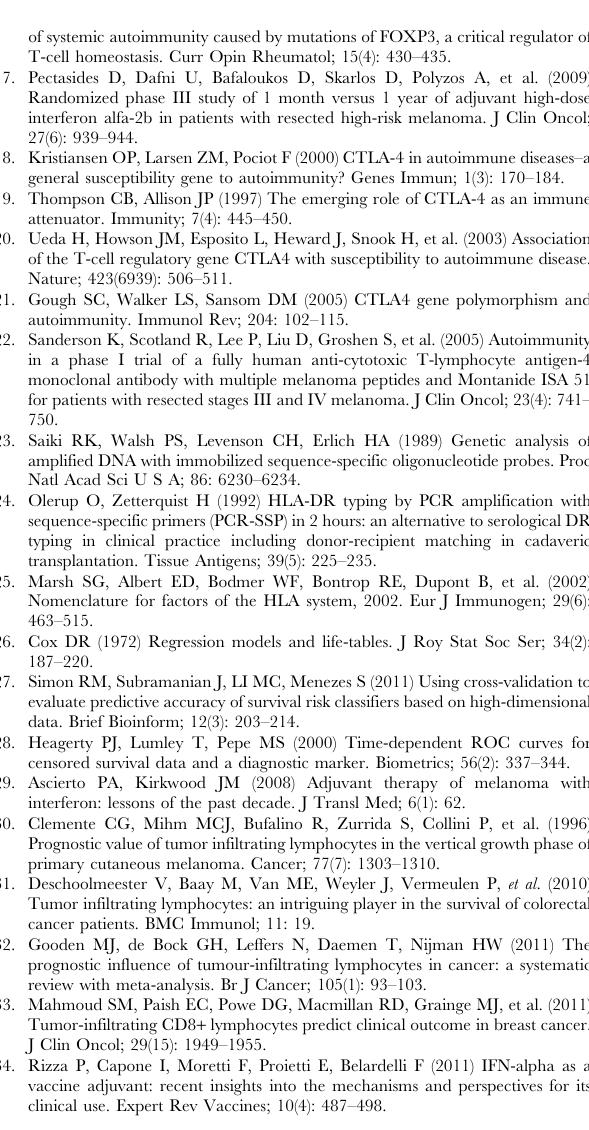
Table S1 Univariate survival analysis for FoxP3 micro-